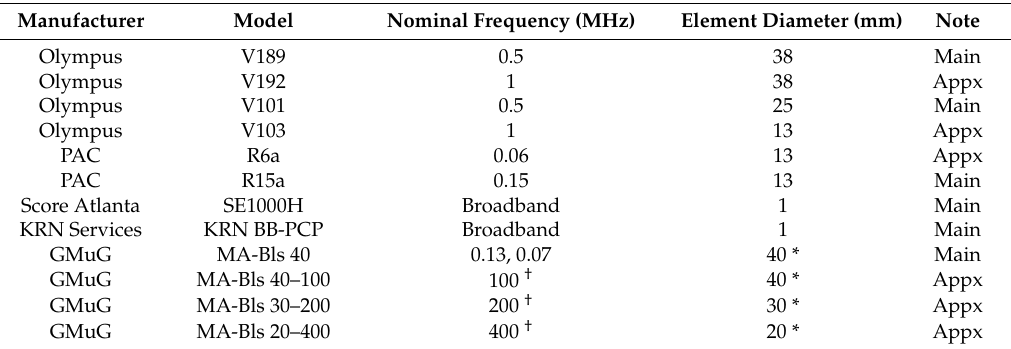
Table 1. UT transducers and AE